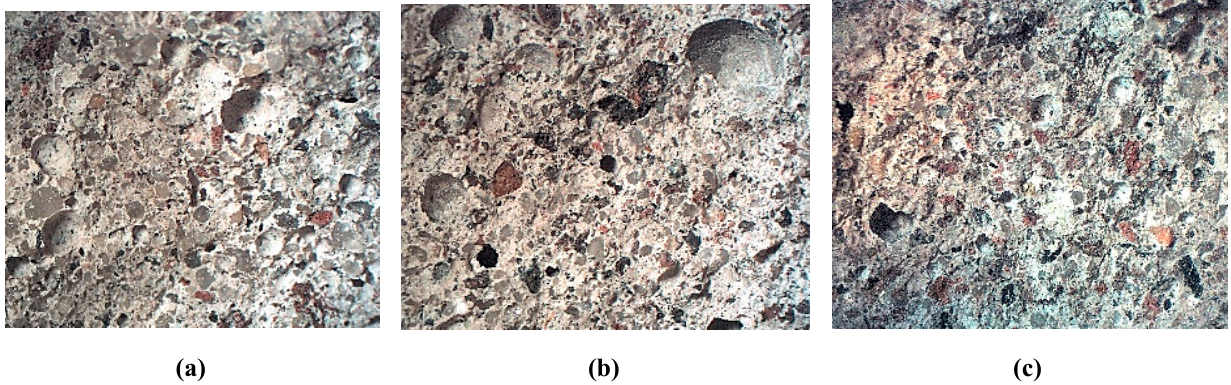
Figure 10. Cross-section of mortars—magnification of 10×, ( a ) 10% of A FSS ; ( b ) 20% of A FSS ; ( c ) 30% of A FSS.